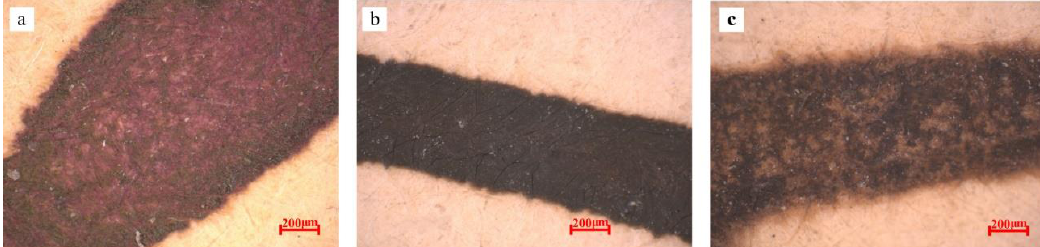
Figure 4. OM images of written documents: ( a ) S1; ( b ) S2; ( c ) S3.